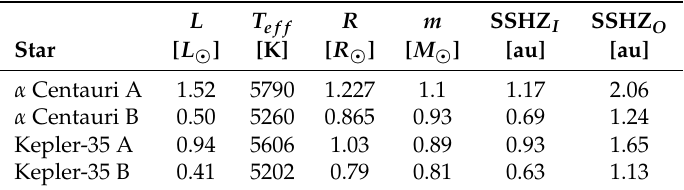
Table 3. Data sheet for α Centauri and Kepler-35, see [37,47–50]. The following orbital parameters have been used for α Centauri: a b = 23.52 au, e b = 0.5179, and Kepler-35: a b = 0.17617 au, e b = 0.1421. SSHZ I , O symbolizes the inner and outer single star HZ border,